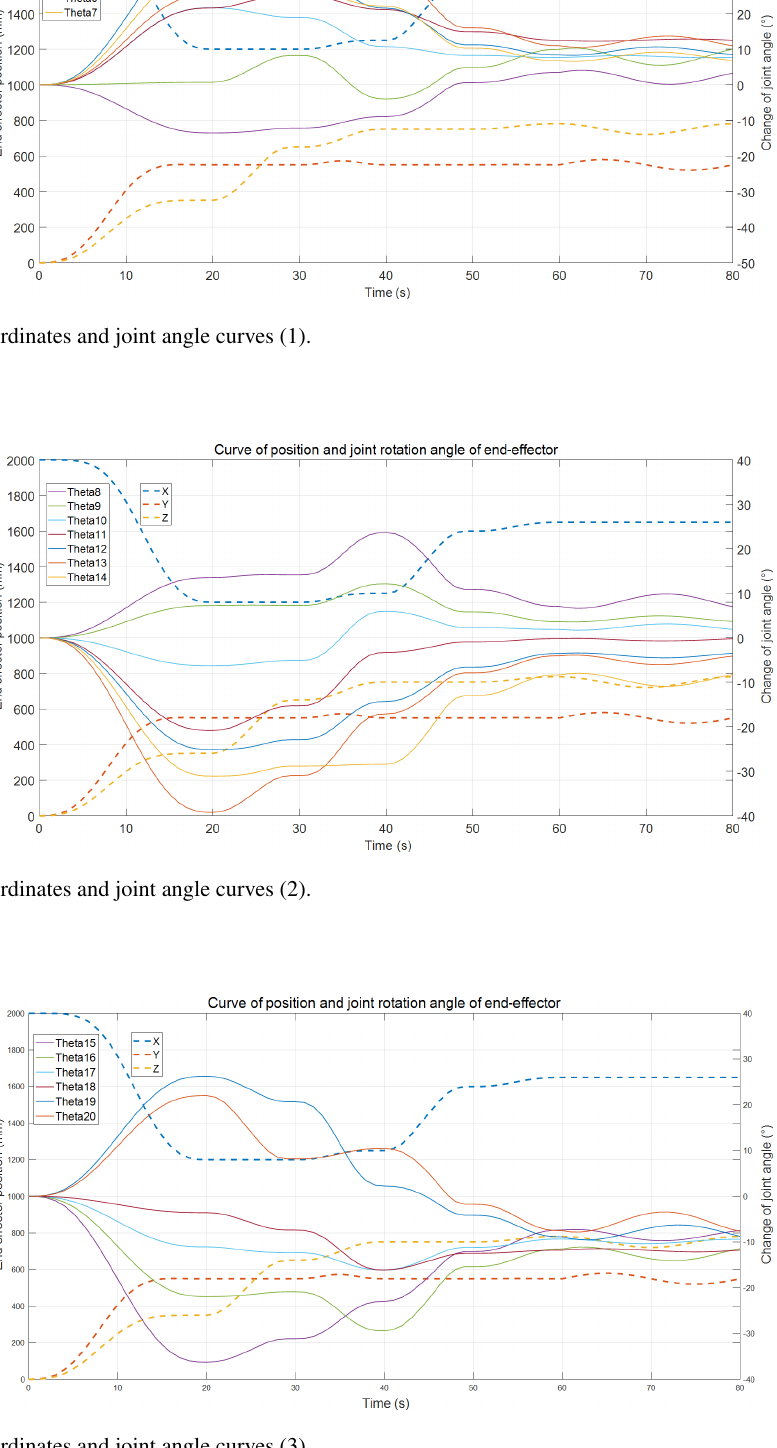
Figure 8. End-effector coordinates and joint angle curves